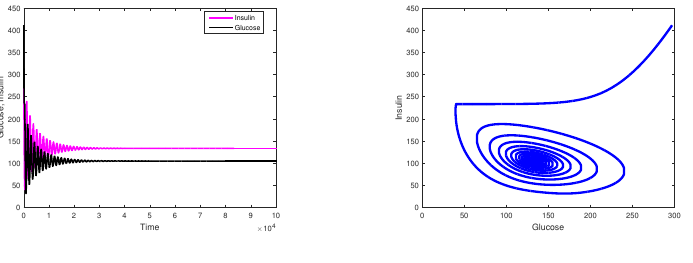
Figure 4. Glucose-insulin dynamics: dynamics and phase plain for τ = 400 < τ ∗ = 457 min. E ∗ loses its stability and a Hopf bifurcation occurs, if τ passes through the critical value τ ∗ , as shown in Figure 5.